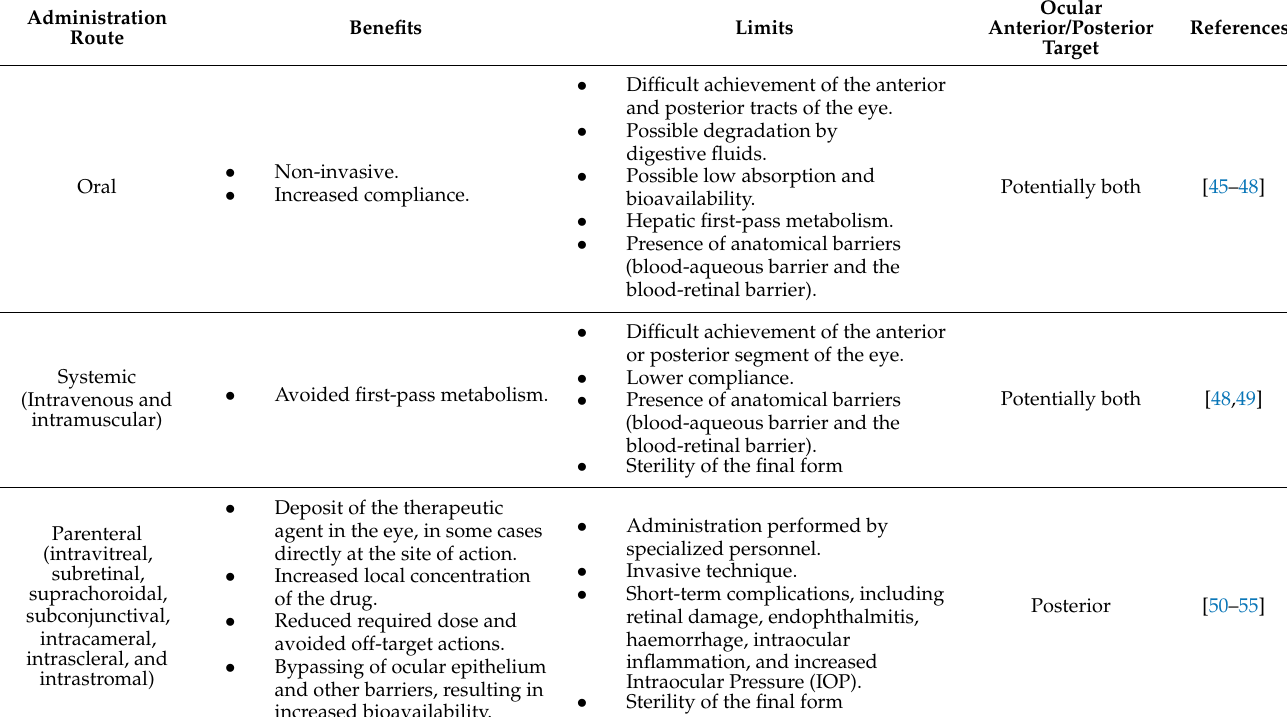
Table 1. Conventional route of ocular delivery: benefits and